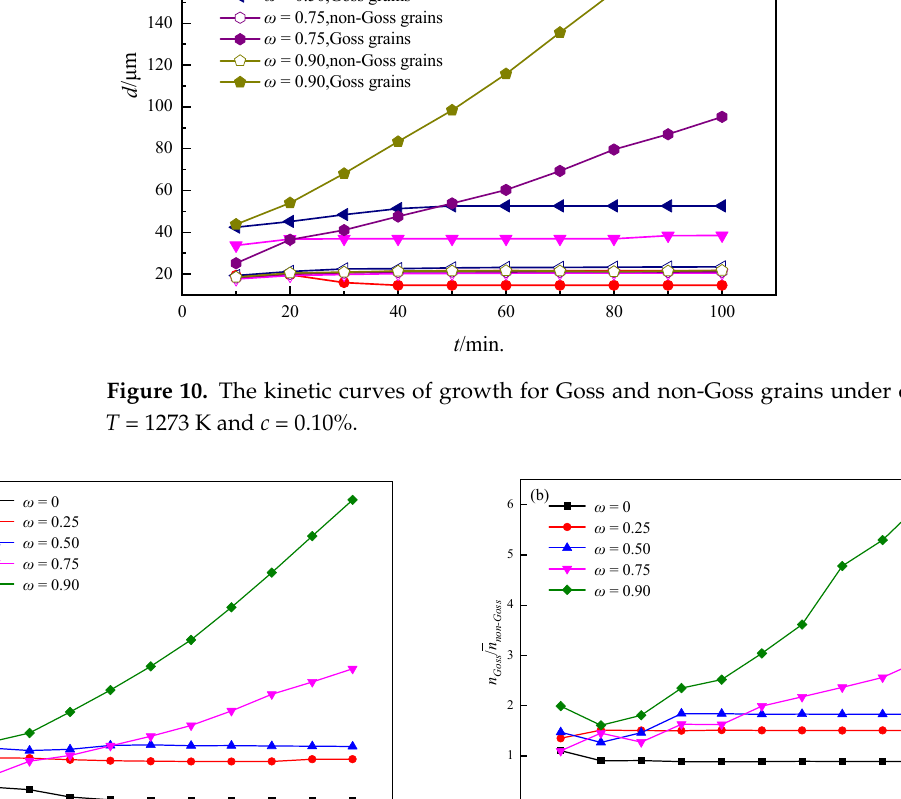
Figure 10. The kinetic curves of growth for Goss and non-Goss grains under different ω s where T = 1273 K and c = 0.10% .